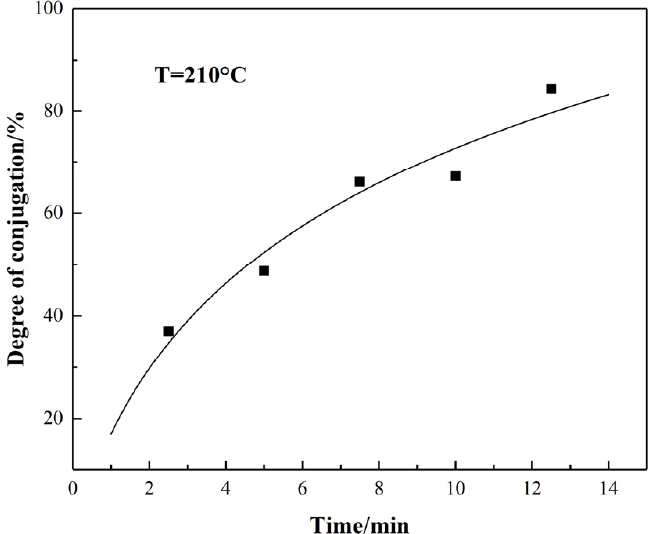
Figure 8. Relationship between the degree of sp 2 hybrid conjugation and time for stabilized PAN fiber.